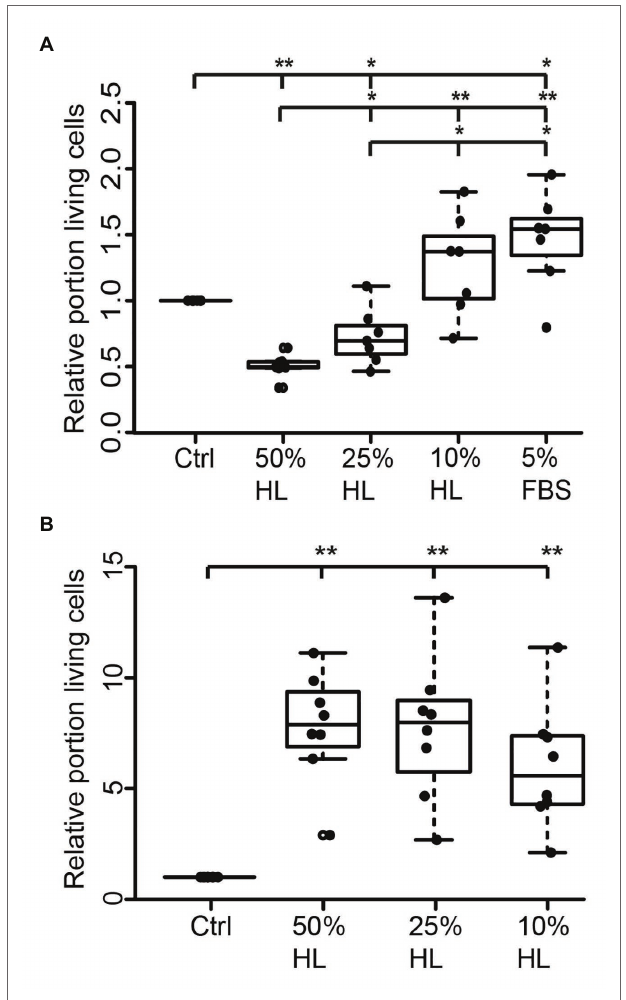
FIGURE 2 | Impact of locust hemolymph on locust neuron survival in vitro . (A) Relative survival of locust neurons after 2 days in vitro with 5% fetal bovine serum (FBS) followed by 3 days in basal L15 culture medium and basal L15 medium supplemented with 5% FBS or 50% hemolymph (HL), 25% HL and 10% HL. About 50 and 25% HL significantly decreased relative survival of neurons in comparison with control. Ten percent HL did not alter neuronal survival. Five percent FBS significantly increased cell survival. n = 7; 106,649 cells evaluated. (B) Relative survival of locust neurons after 2 days in